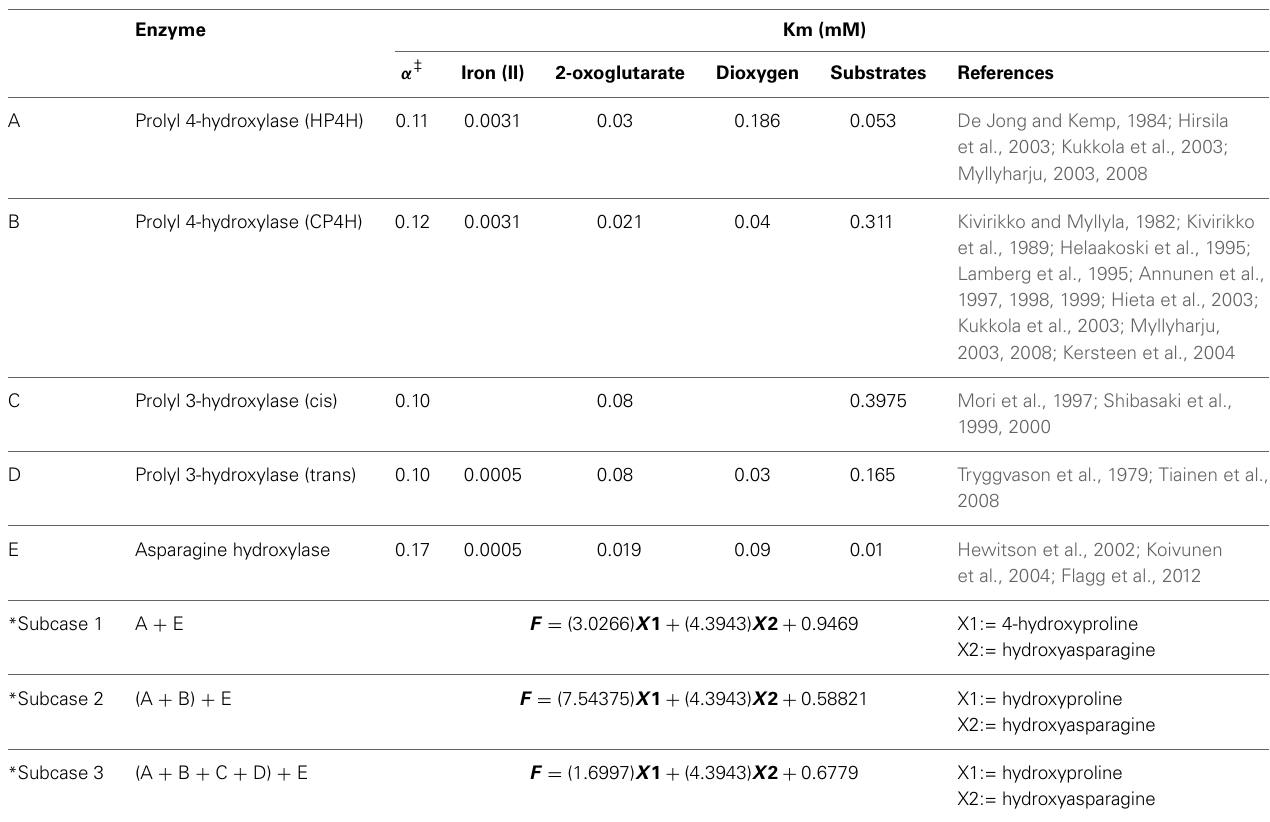
Table 1 | Alpha-ketoglutarate dependent enzymes as mediators of synergistic function.